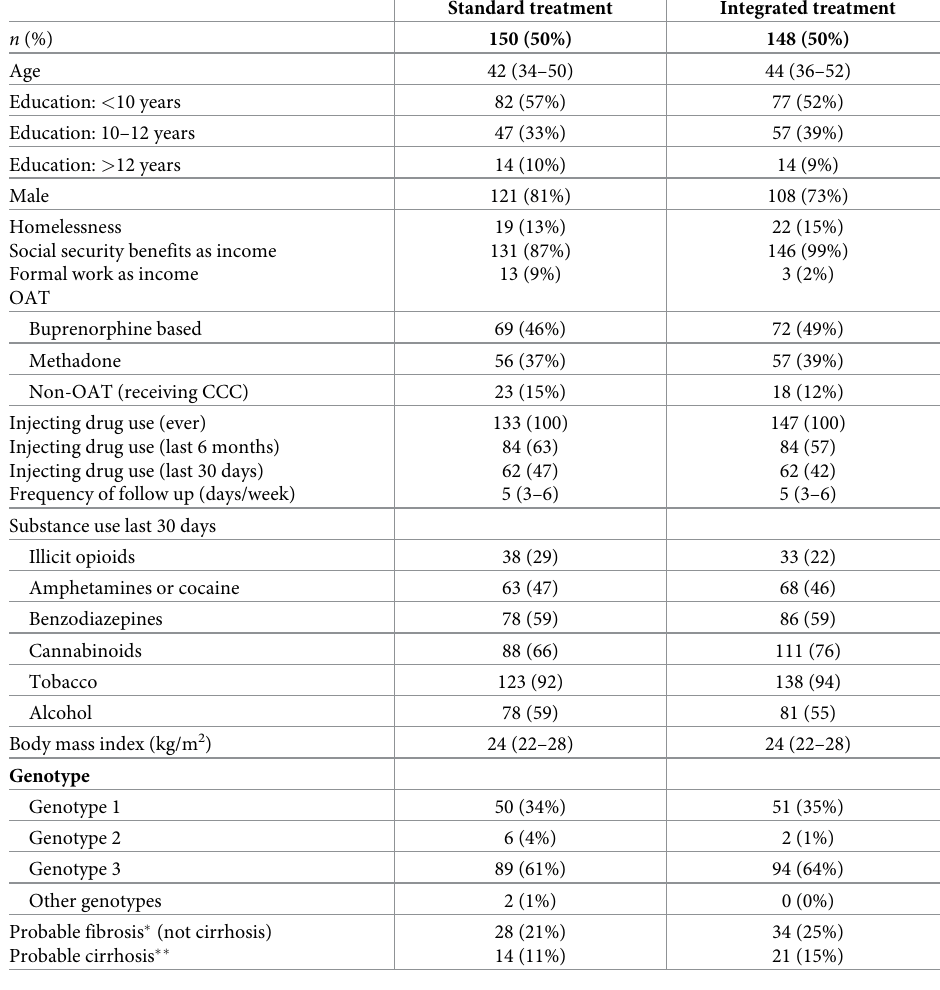
Table 1. Demographic and clinical characteristics at baseline for participants in standard and integrated treat- ment groups presented with numbers in each group with percentages or median (25%–75%) for age and body mass